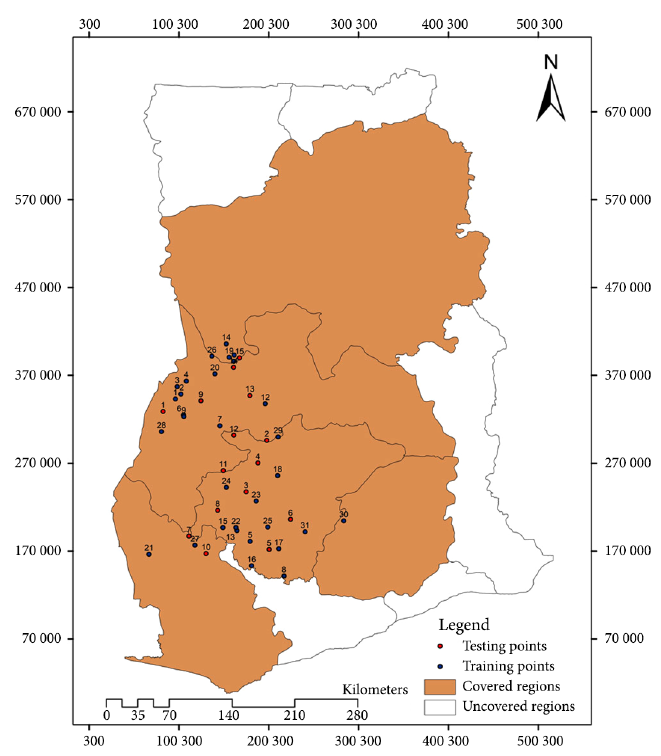
Figure 2. Training and testing data distribution